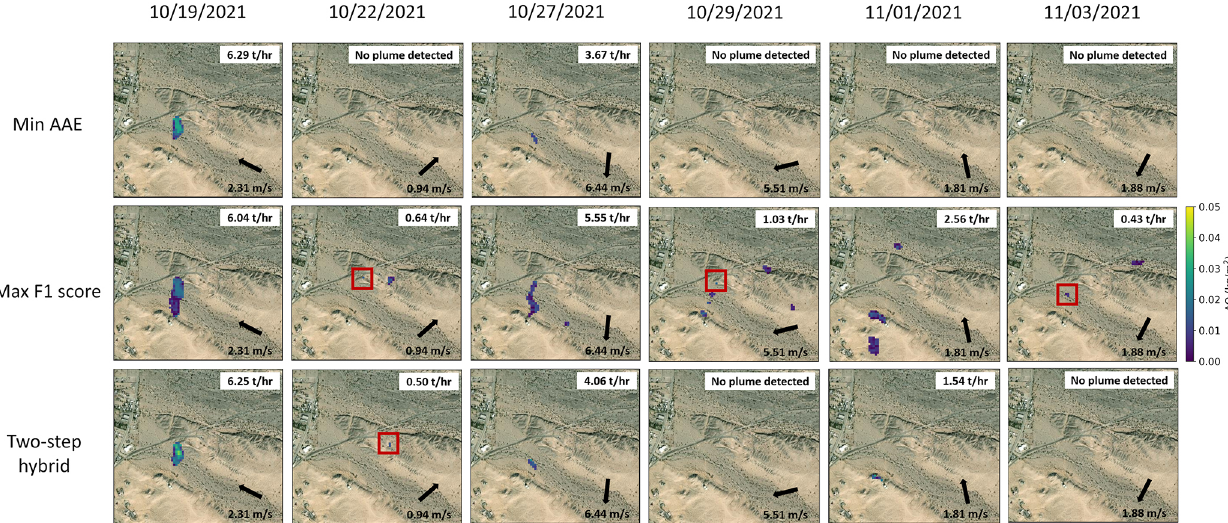
Figure 6. Locations and shapes of the detected plumes. All the dates with plumes detected in “min AAE”, “max F 1 score”, and “two-step hybrid” scenarios are shown. Plumes that are too small with only few pixels are marked in red, although they are not necessarily the full plume extent. Each figure also has the methane plume emission rate shown in the upper-right area and wind speed and direction shown in the lower-right area. Note that the plumes at 1 November 2021 are false positives since the ground-truth volume in this day is 0, and the dates with multiple plumes detected are also likely to include false positives, although this is hard to validate. The basemap is the ArcGIS Online World Imagery Basemap. The sources for the data used are as follows: Esri, DigitalGlobe, GeoEye, i-cubed, USDA FSA, USGS, AEX, Getmapping, Aerogrid, IGN, IGP, swisstopo, and the GIS User Community.